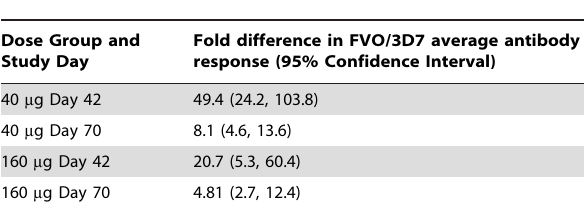
p , 0.0001 for all tests.